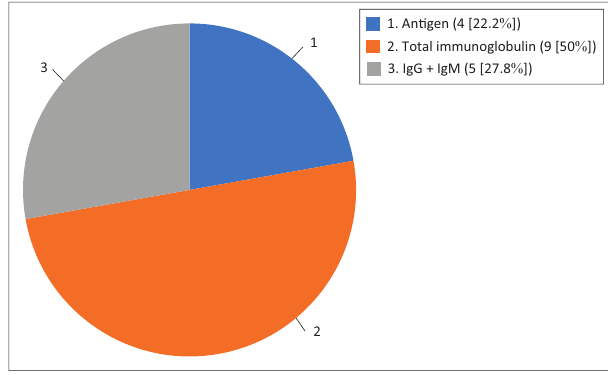
FIGURE 3: Distribution of the serological rapid diagnostic tests by testing principle.